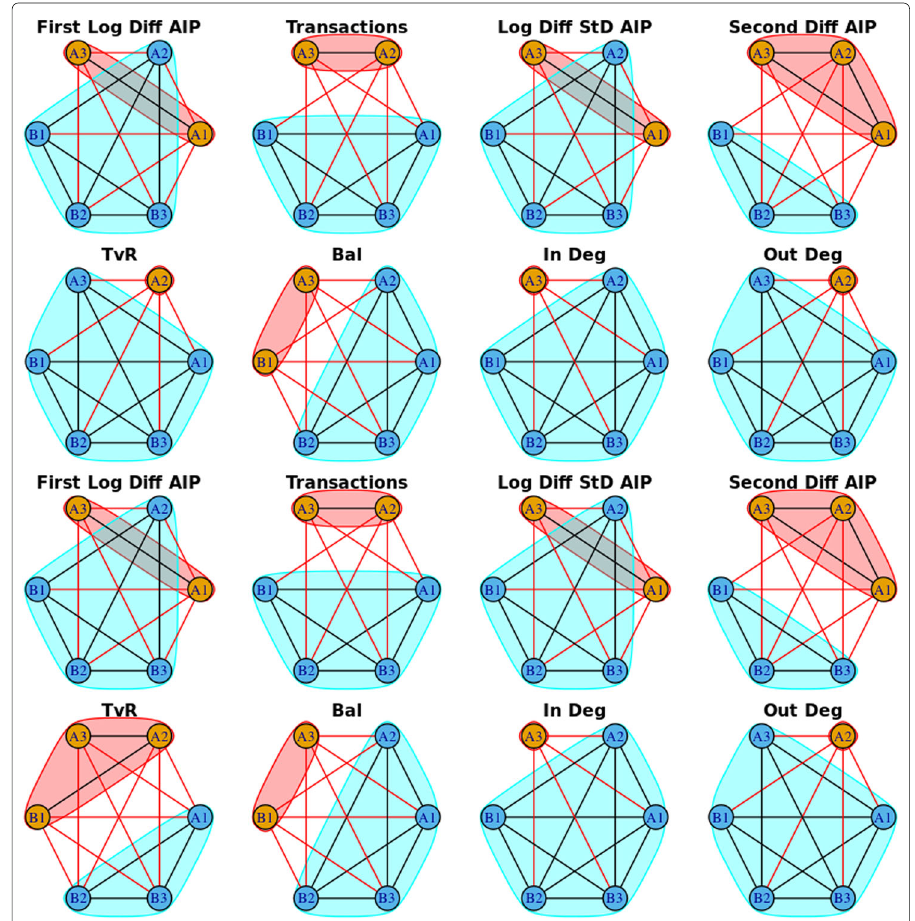
Fig. 10 Communities for all features’ similarity matrices - First by Walktrap then Modularity Optimization